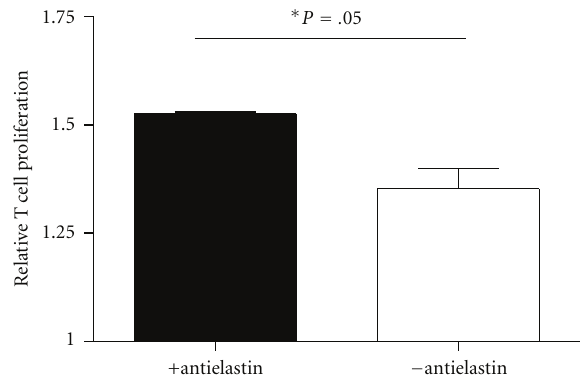
Figure 5: E ff ect of depletion of antielastin antibodies from Z- A1ATD BALF on T cell proliferation. T cell proliferation was measured in (1 × 10 5 ) CD3-activated Jurkat T cells treated for 24 hours at 37 ◦ C with intact Z-A1ATD BALF (500 μ L) or BALF from which antielastin antibodies had been depleted ( n =